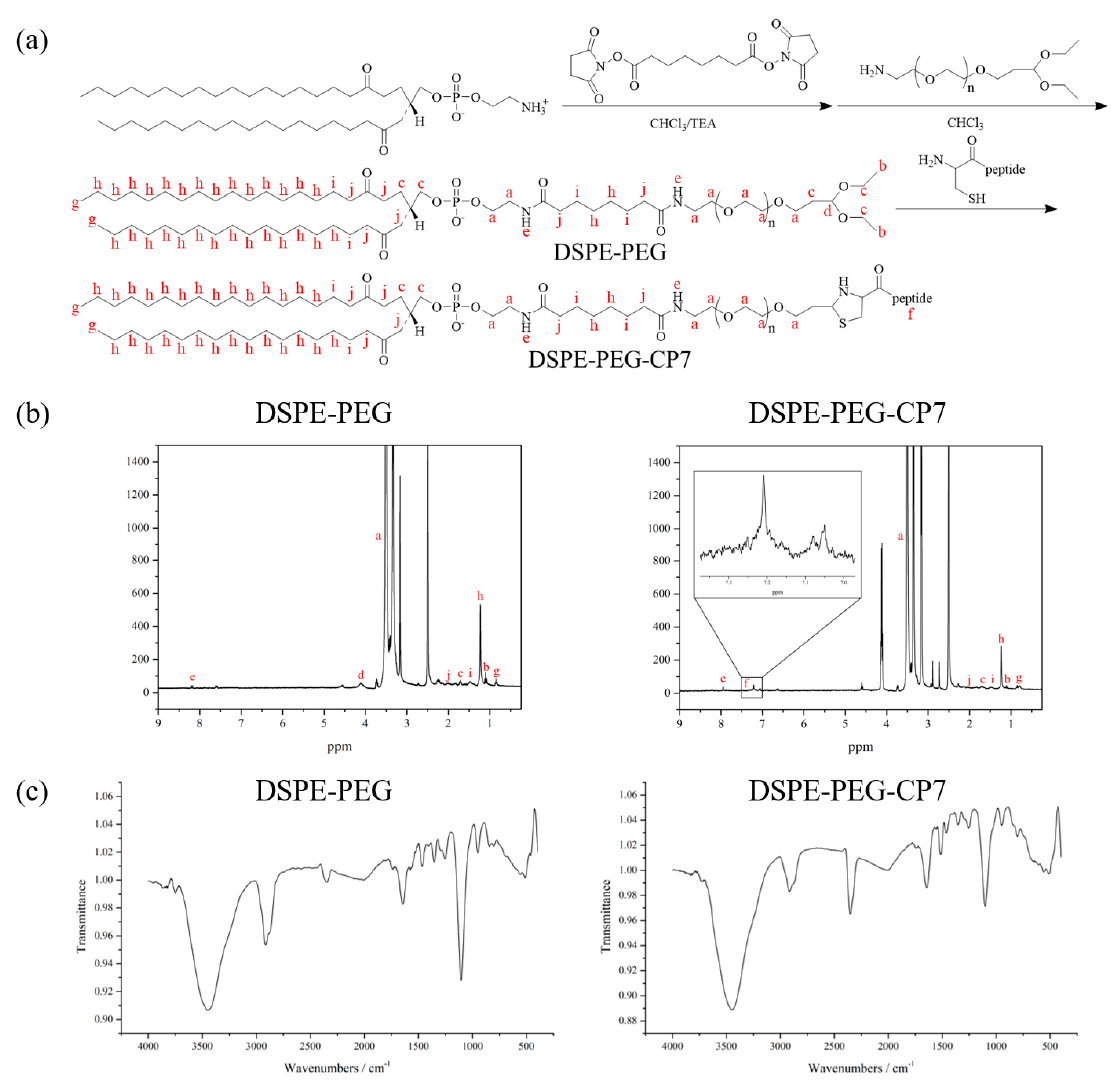
Figure 2. Synthetic route ( a ), 1 H − NMR spectra ( b ), and FT − IR spectrum ( c ) of DSPE-PEG and DSPE-PEG-CP7.